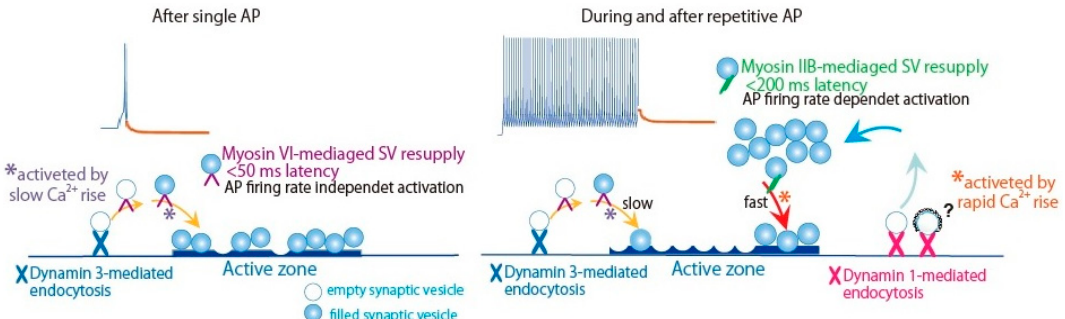
Figure 5. Neural activity selects Myosin IIB and VI in distinct dynamin isoform-mediated SV resupply pathways. Schematic drawing of SV resupply to the release site by myosin VI and IIB through distinct SV membrane recycling pathways mediated by dynamin isoforms. *purple, SV reloading activated by slow Ca 2+ rise; *orange, SV reloading activated by rapid Ca 2+ rise. ?, Clathrin-coated vesicle endocytosis is under debated [3,13]. SV clusters are classified into two pools: release-readily vesicles on the active zone membrane [57] and replacement site vesicles [8]. Adapted from Lu et al., 2009 [60]; Tanifuji et al., 2013 [85]; Mori et al., 2014 [86]; Hayashida et al., 2015 [64].